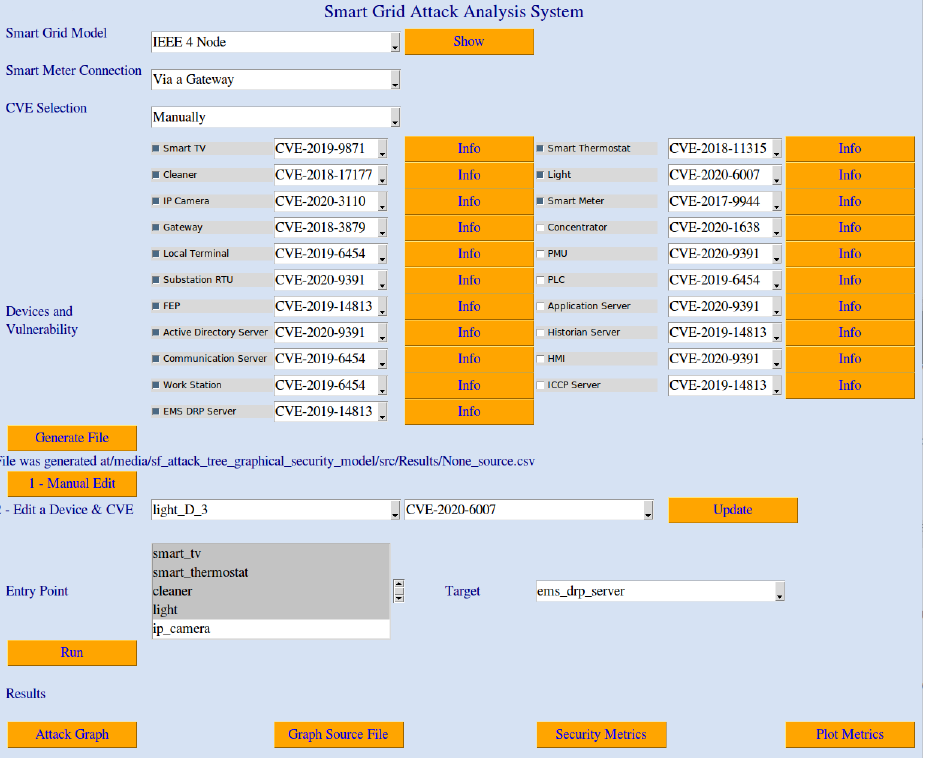
Figure 2. GridAttackAnalyzer desktop